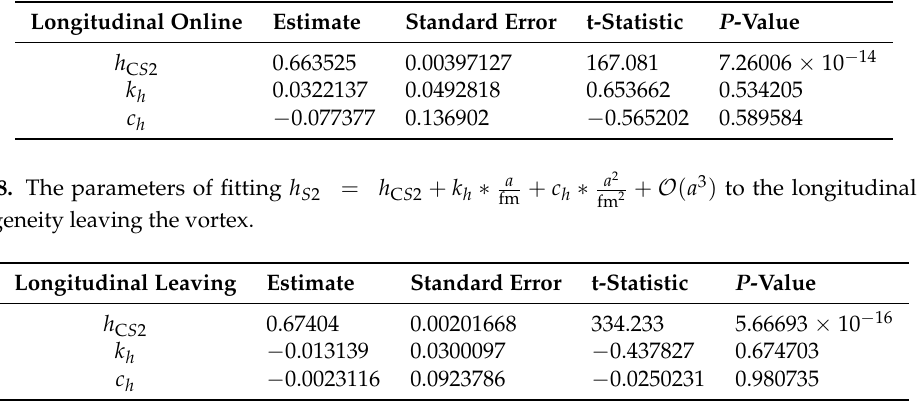
Table 7. The parameters of fitting h S 2 = h C S 2 + k h homogeneity online the vortex. Comparing the value for h S 2 along the vortex with the value of the vacuum in Table 4, the color vector fluctuates strongly along the vortex.